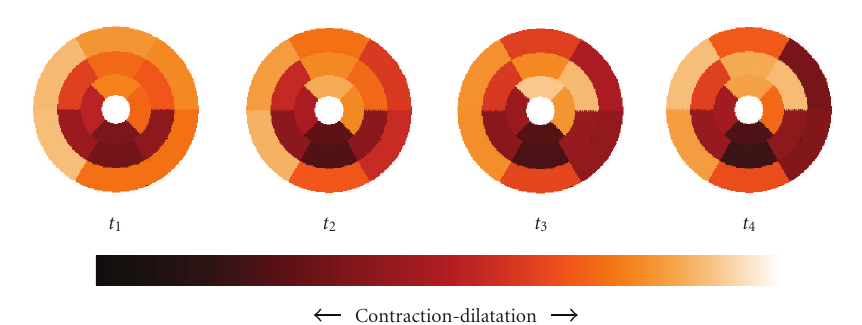
Figure 10: Radial contraction of the heart represented in accordance with the AHA’s